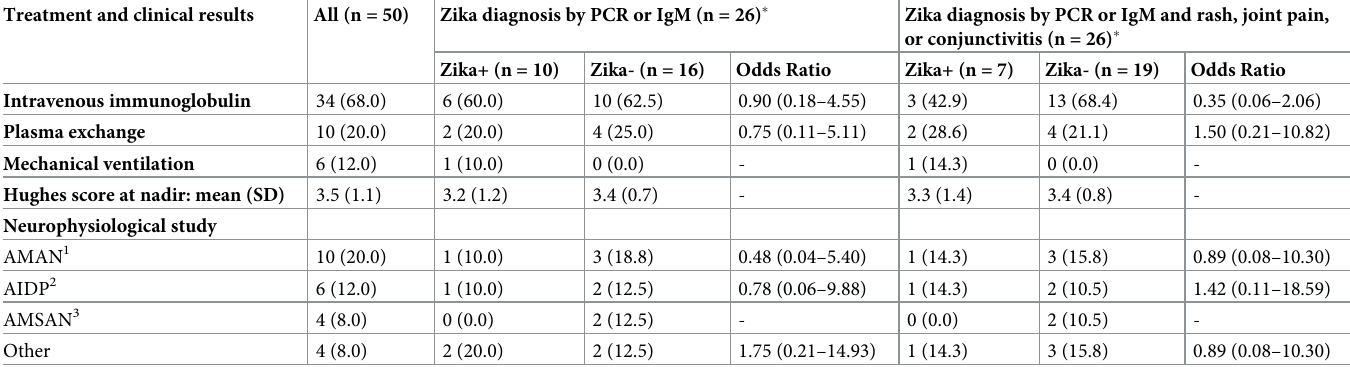
Table 7. Treatment and clinical results for GBS case-patients by Zika status: n (%). Treatment and clinical